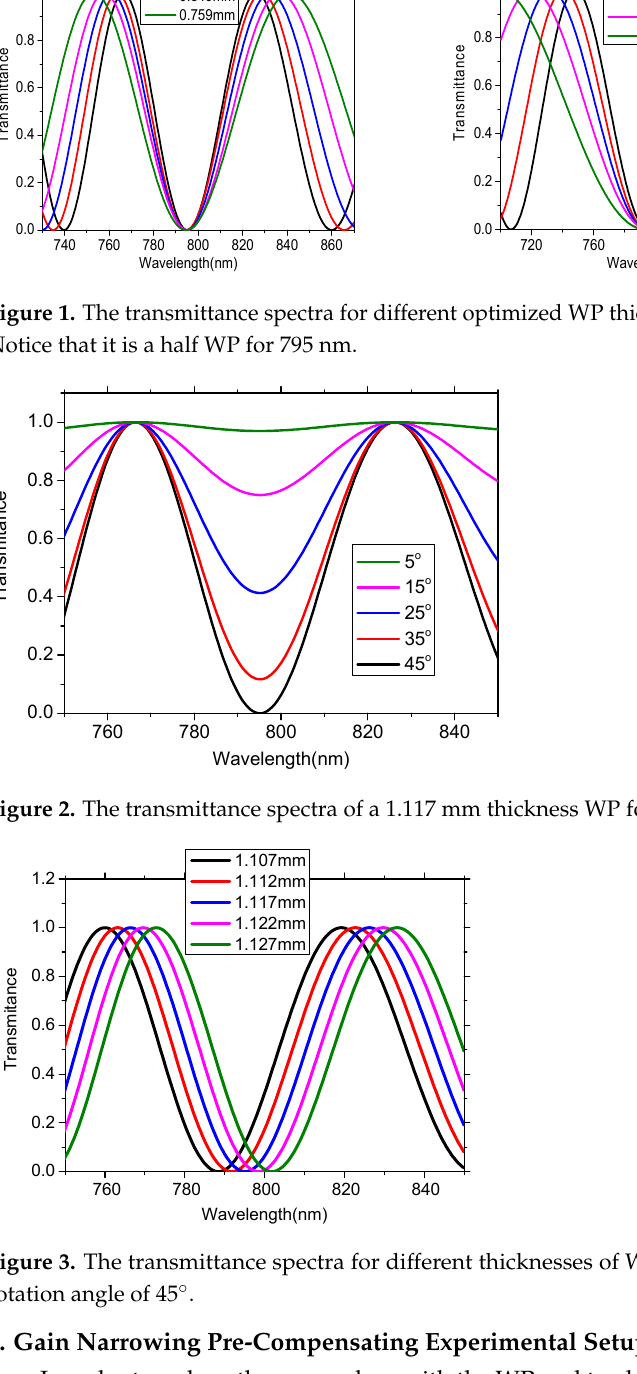
Figure 3. The transmittance spectra for different thicknesses of WPs around 1.117 mm and with a rotation angle of 45 ◦